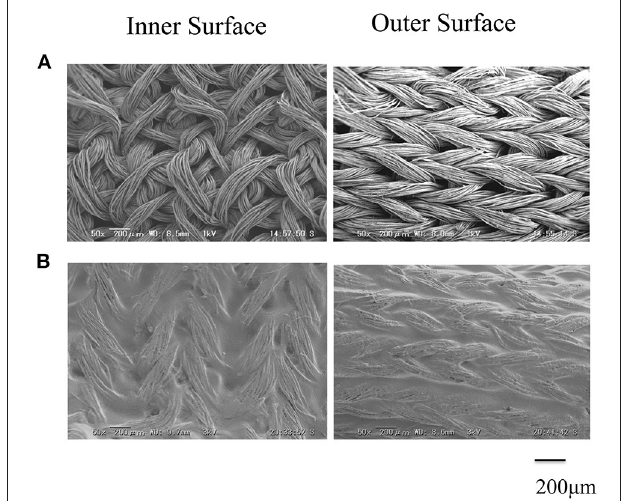
FIGURE 2 | Scanning electron microscope images of (A) double-raschel knitted silk fibroin (SF) vascular graft and (B) elastin (EL)–SF knitted graft. The inner and outer surfaces of the SF graft appear to be properly coated by